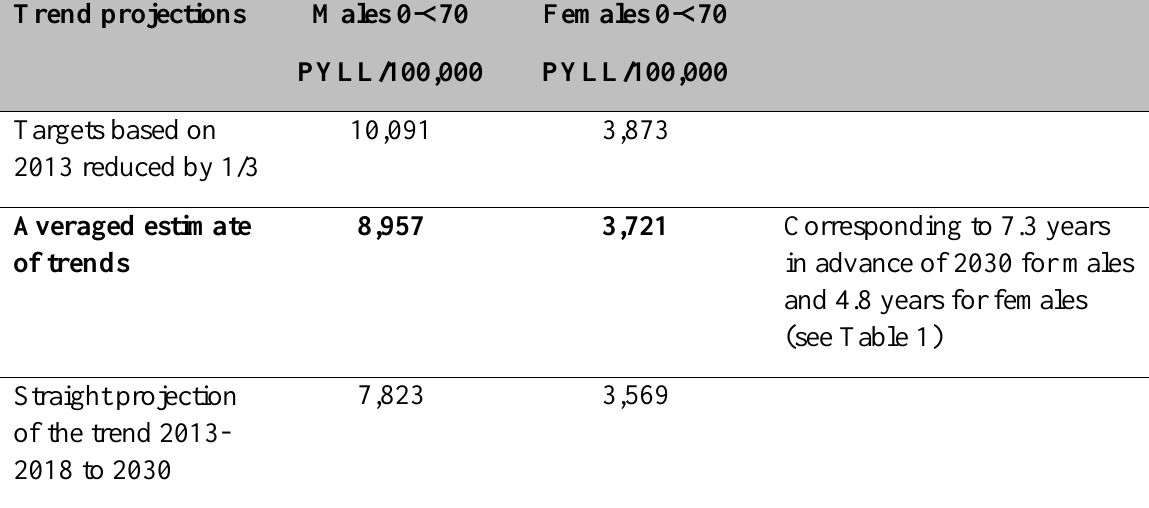
Table 2. Projected reduction of Premature Years of Life Lost (PYLL) targeted 2013-2030 for both sexes separately with levels of